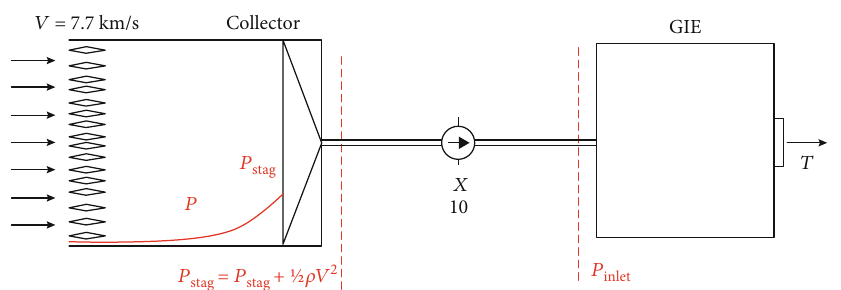
Figure 10: Schematic diagram showing the collector concept (ESA) [31].